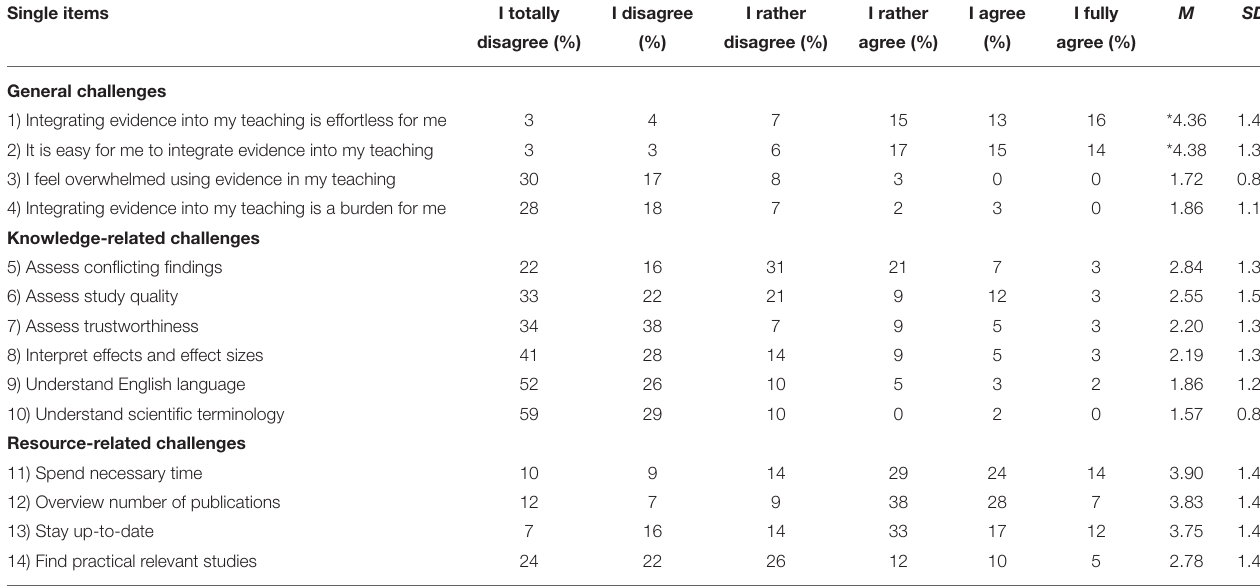
TABLE 3 | Descriptive statistics for perceived challenges: percentage of nominations, mean scores (M), and standard deviation (SD) of the single items. Single items